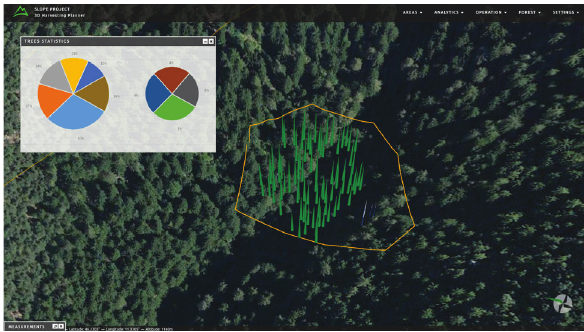
Figure 11. Forest inventory with spatial query and statistics